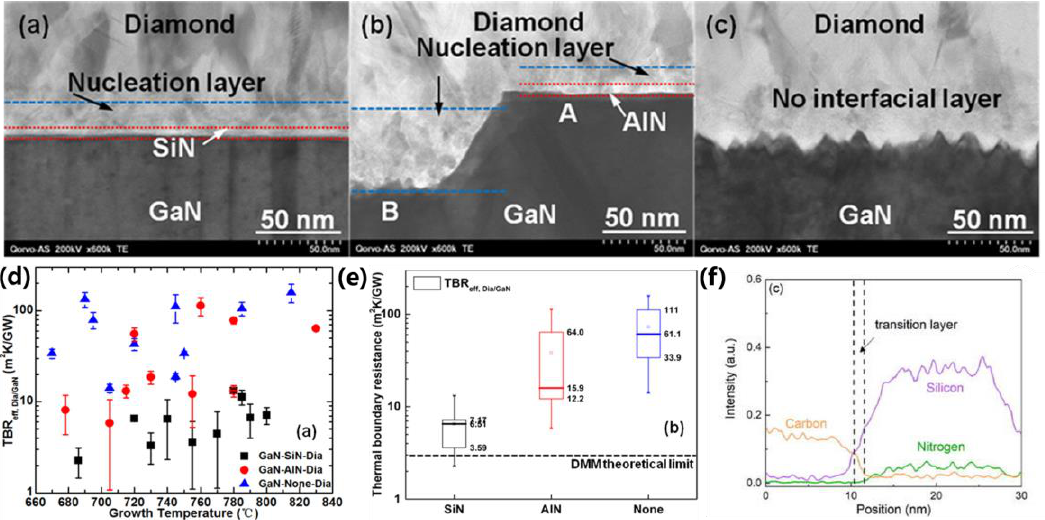
Figure 9. Cross-section TEM images [106], ( d , e ) effective thermal boundary resistance of GaN/barrier layer/diamond interface, and ( f ) EDS results of diamond/SiN/GaN interface [107]. ( a ) SiN, ( b ) AlN, and ( c ) no-barrier layer.